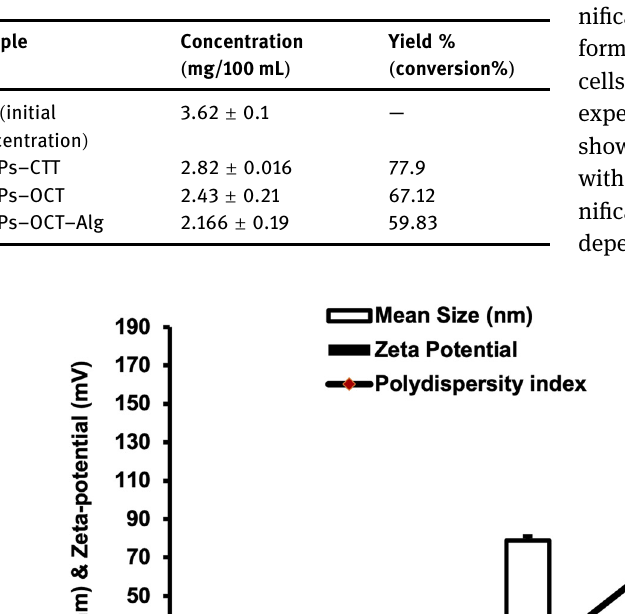
Table 1: The yield percentage of Ag° in AgNPs after conversion of